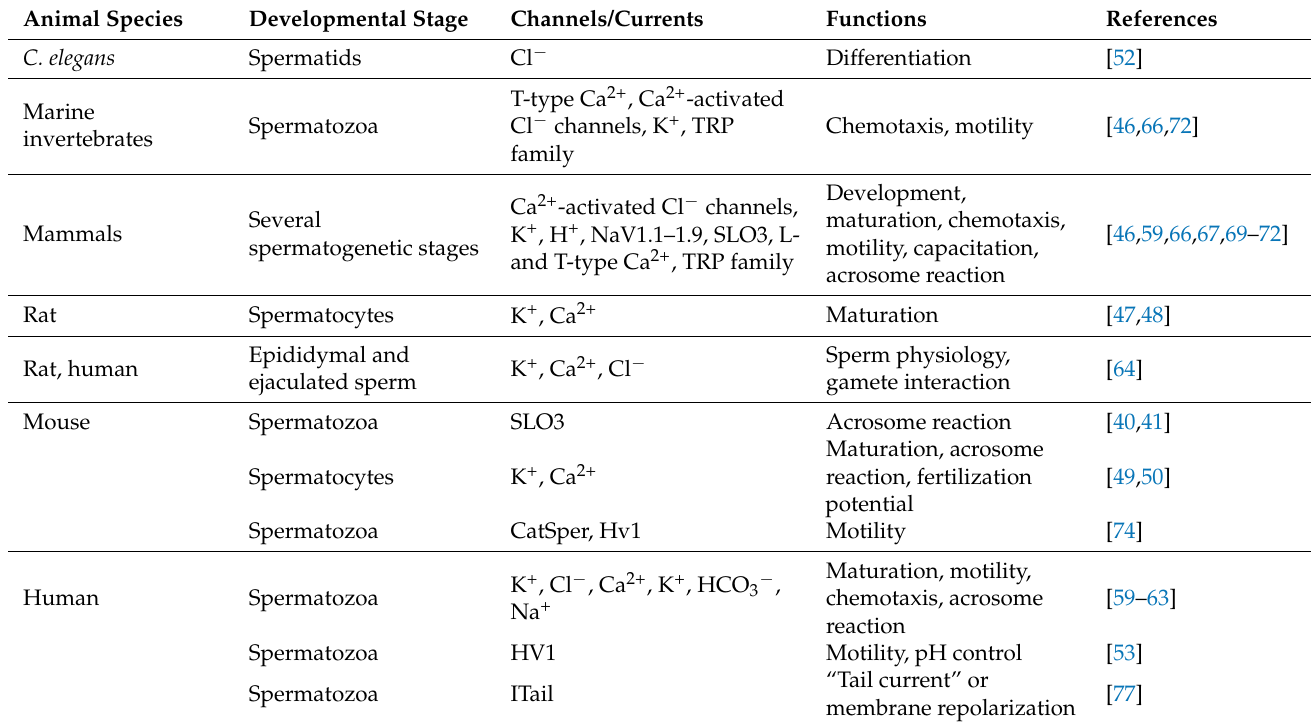
Table 2. Types and functions of ion channels/currents involved in animal and human